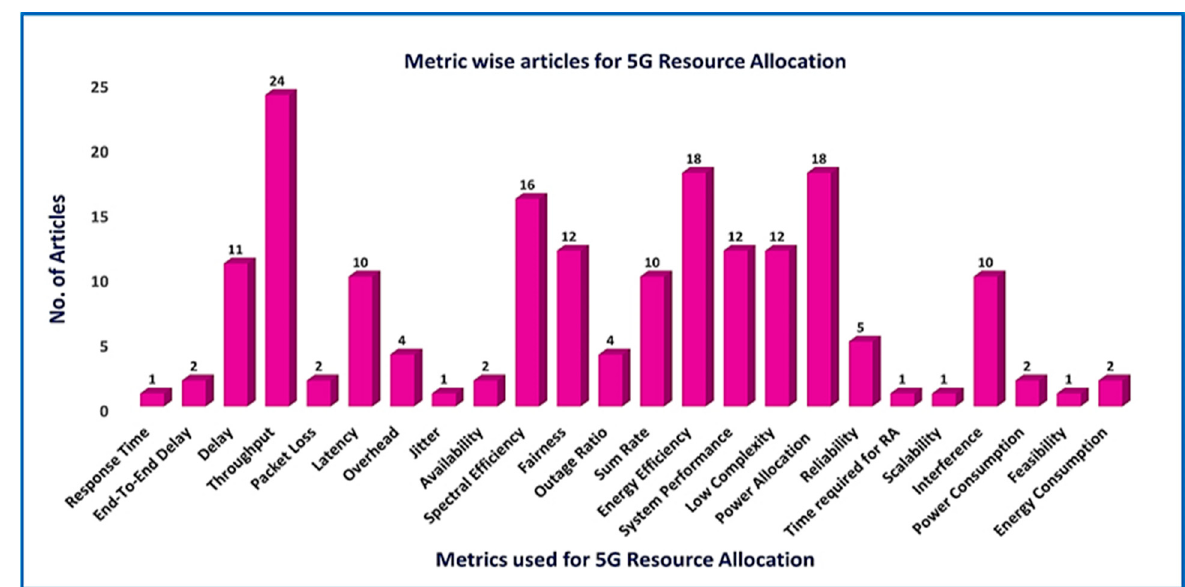
Figure 9. Analysis of metrics used for 5G resource allocation.